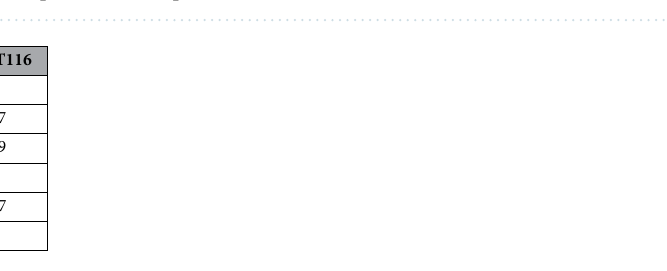
Figure 3. DDR inhibitors sensitized cancer cells to X-ray radiation. Clonogenic survival after combining DNA- PKi (200 nM) and radiation ( A ), ATMi (200 nM) and radiation ( B ). The cells were treated 2 h prior to radiation, then incubated for 24 h and reseeded for colony formation. Statistical analysis: 2way ANOVA, Tukey’s multiple comparisons test; (*) p < 0.05, (**) p < 0.01, (****) p < 0.0001.